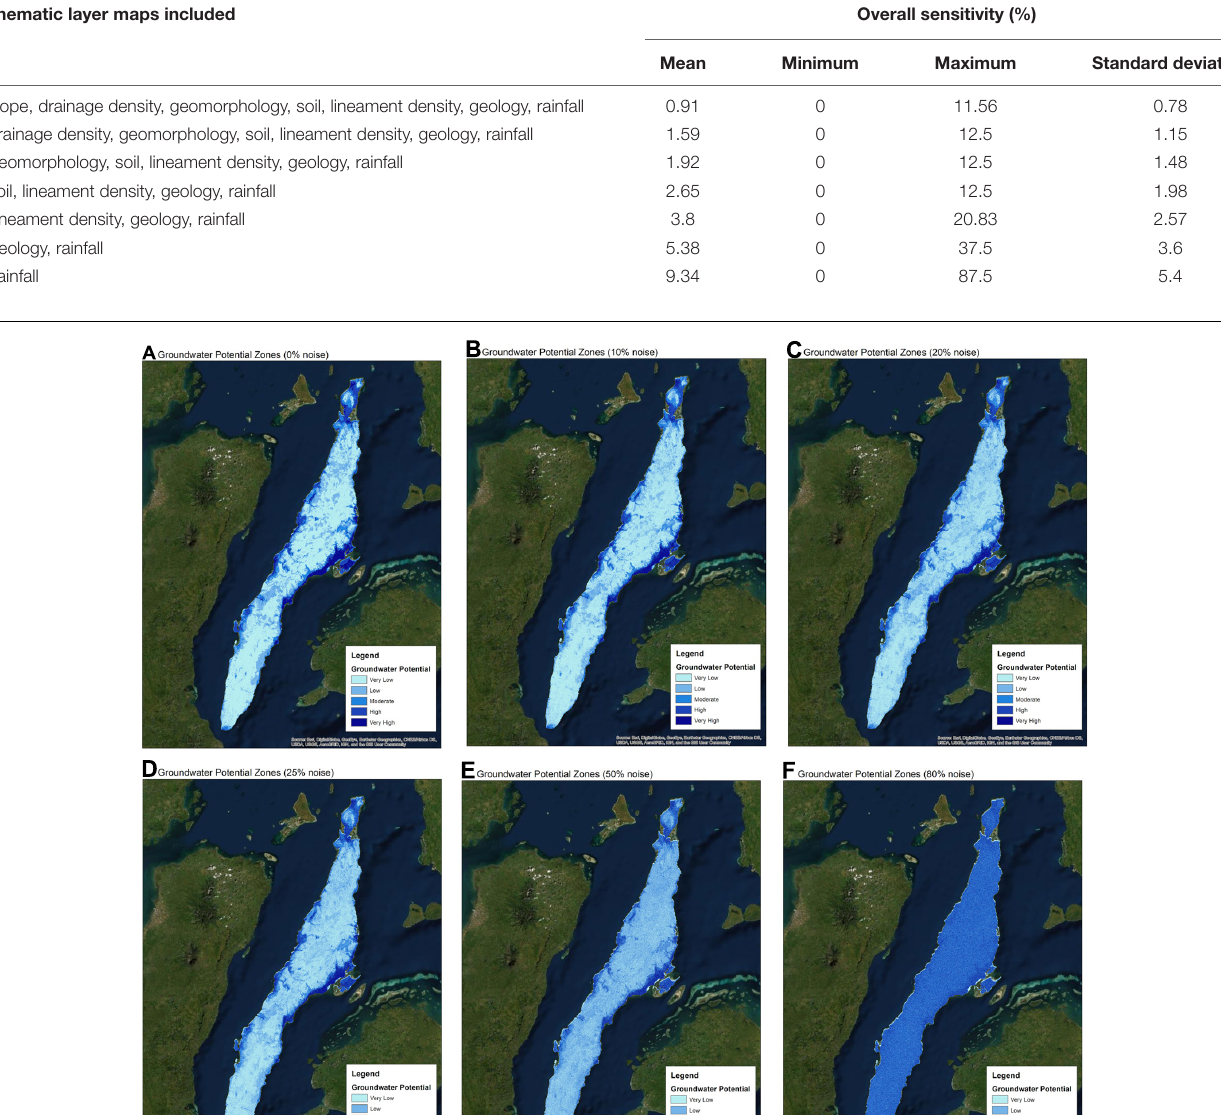
TABLE 2 | Statistics of the map removal sensitivity analysis.